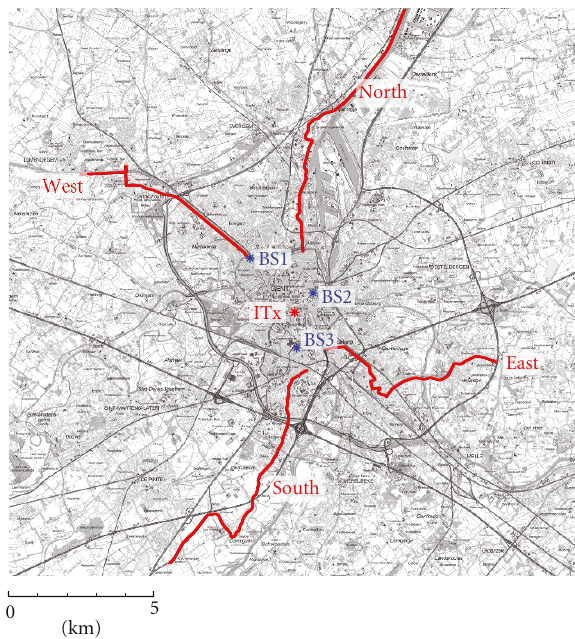
Figure 1: Map of Ghent with the three transmitting DVB-H antennas, the “imaginary transmitter” ITx, and the routes (in red) used to determine the